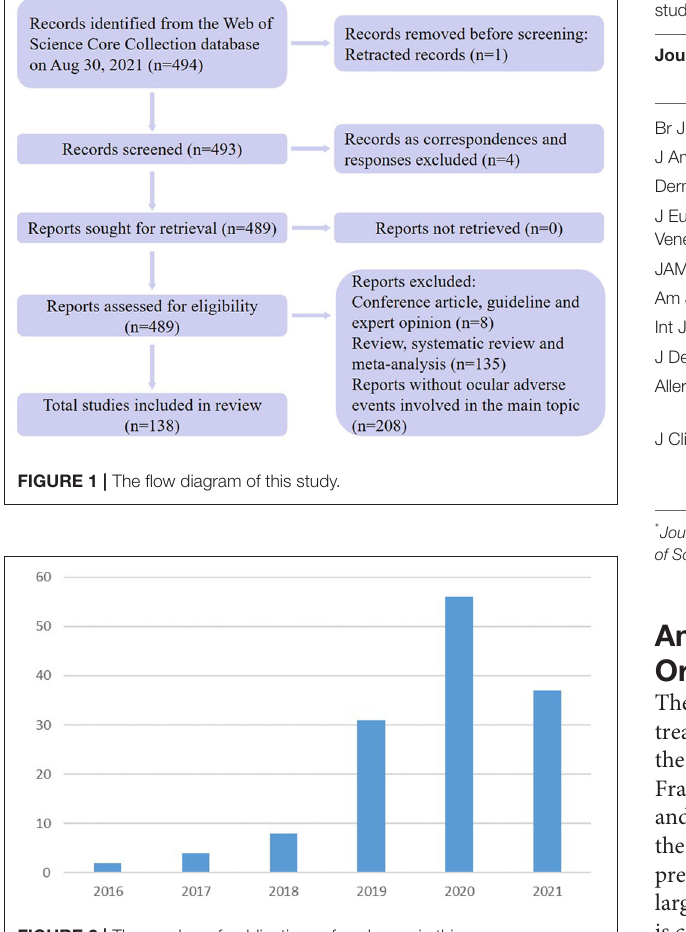
FIGURE 2 | The number of publications of each year in this area.